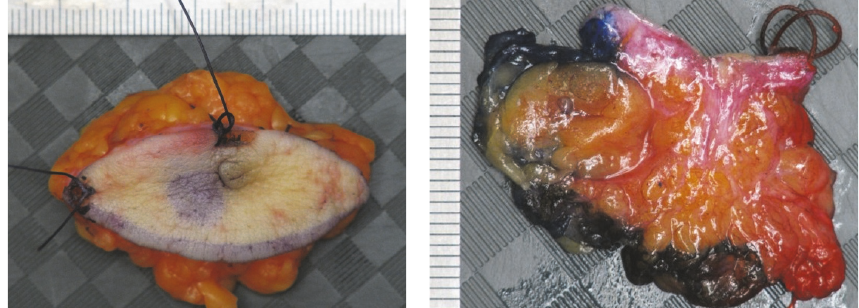
Figure 4: Excised supernumerary nipple specimen marked as a lumpectomy.